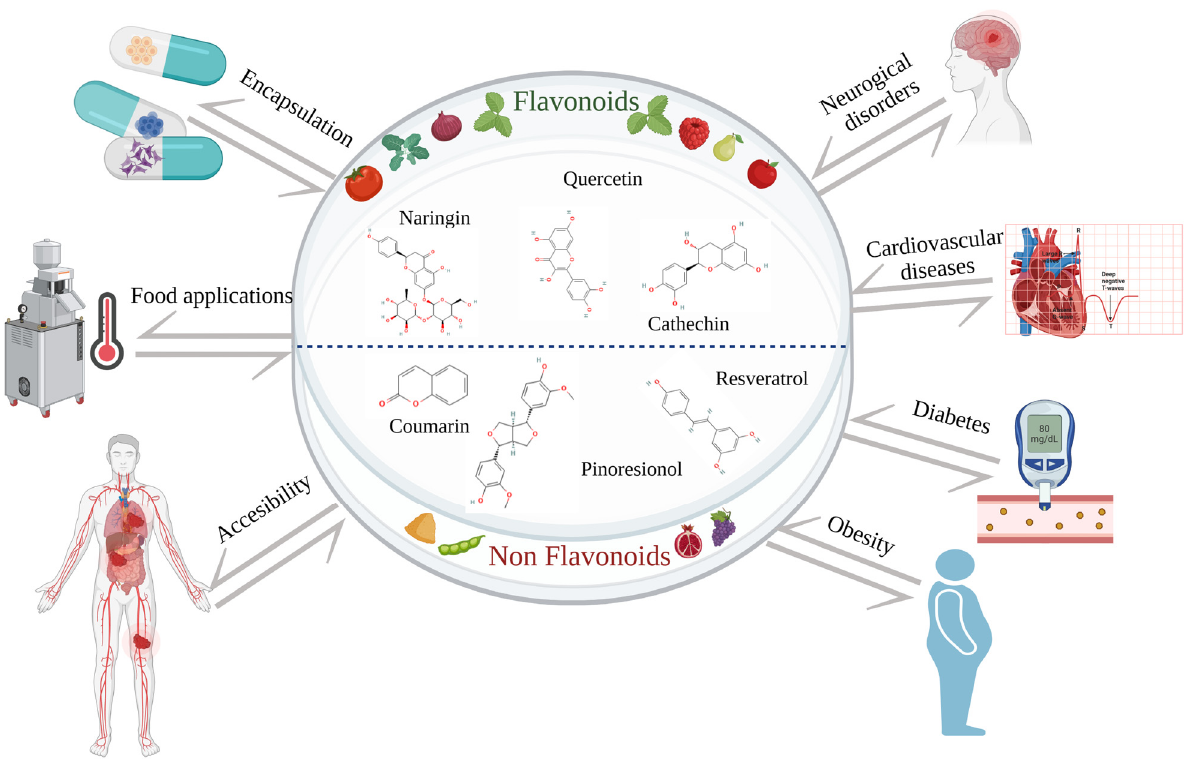
Figure 2. Future directions to increase accessibility of polyphenols from food, and their impact on human health .